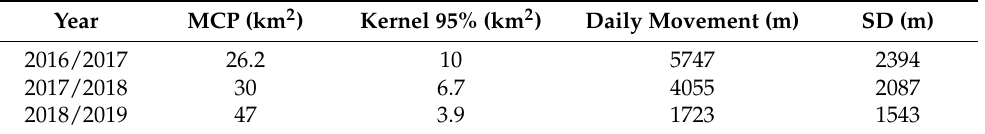
Table 3. MCP, kernel 95%, and daily movement values in the monitored winter